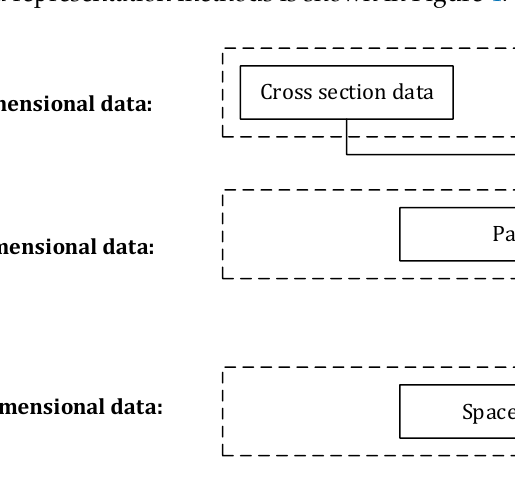
Figure 4. Relationships of several data representation methods.